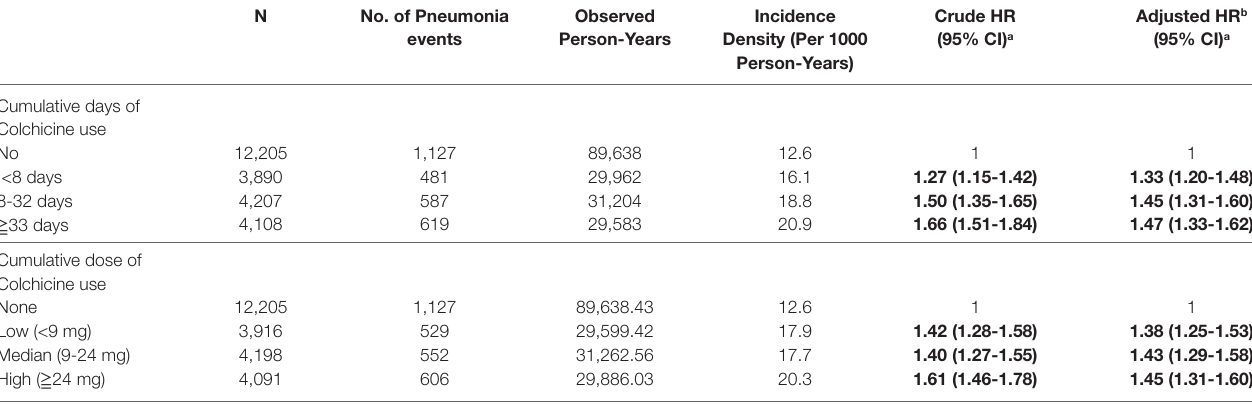
TABLE 4 | Analysis of pneumonia risk in gout patients based on Colchicine dose and duration using Cox proportional hazard model.